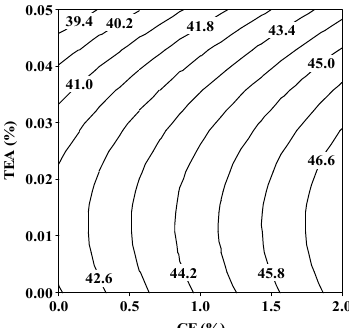
Figure 4. Effect of CF, TIPA and SS on the 3 d strength of cement mortars: ( a ) CF vs. SS (no TIPA), ( b ) CF vs. SS (0.05% TIPA), ( c ) CF vs. TIPA, ( d ) SS vs. TIPA.